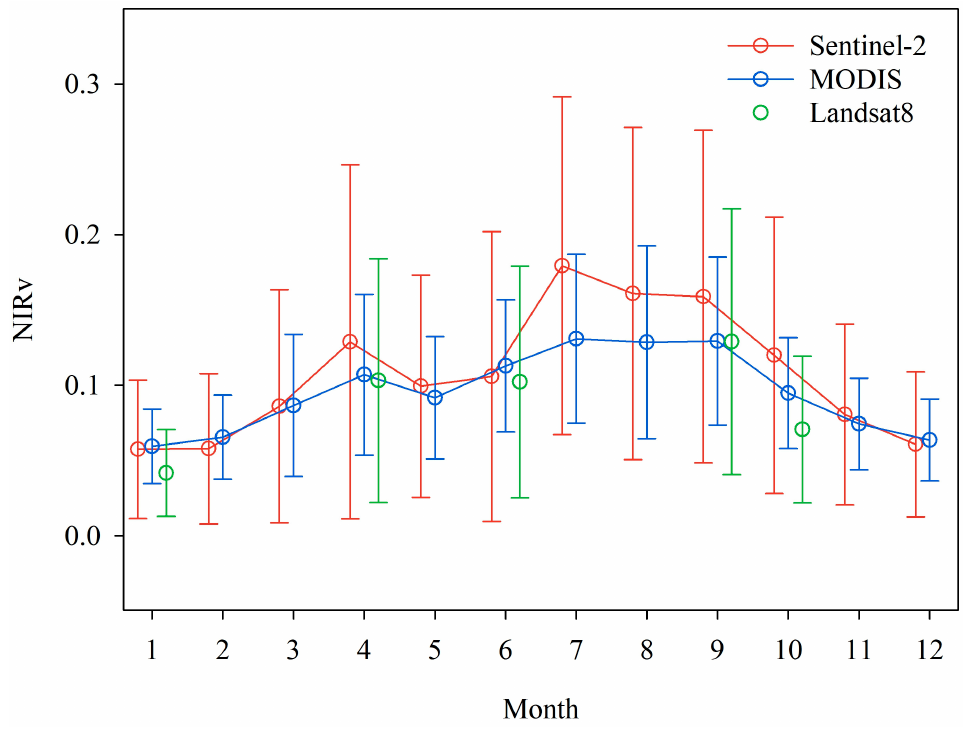
Figure 3. Monthly averages (red, blue and green cycle) and standard deviations (red, blue and green bar) of NIRv in Suzhou derived from MODIS, Landsat-8 and Sentinel-2.